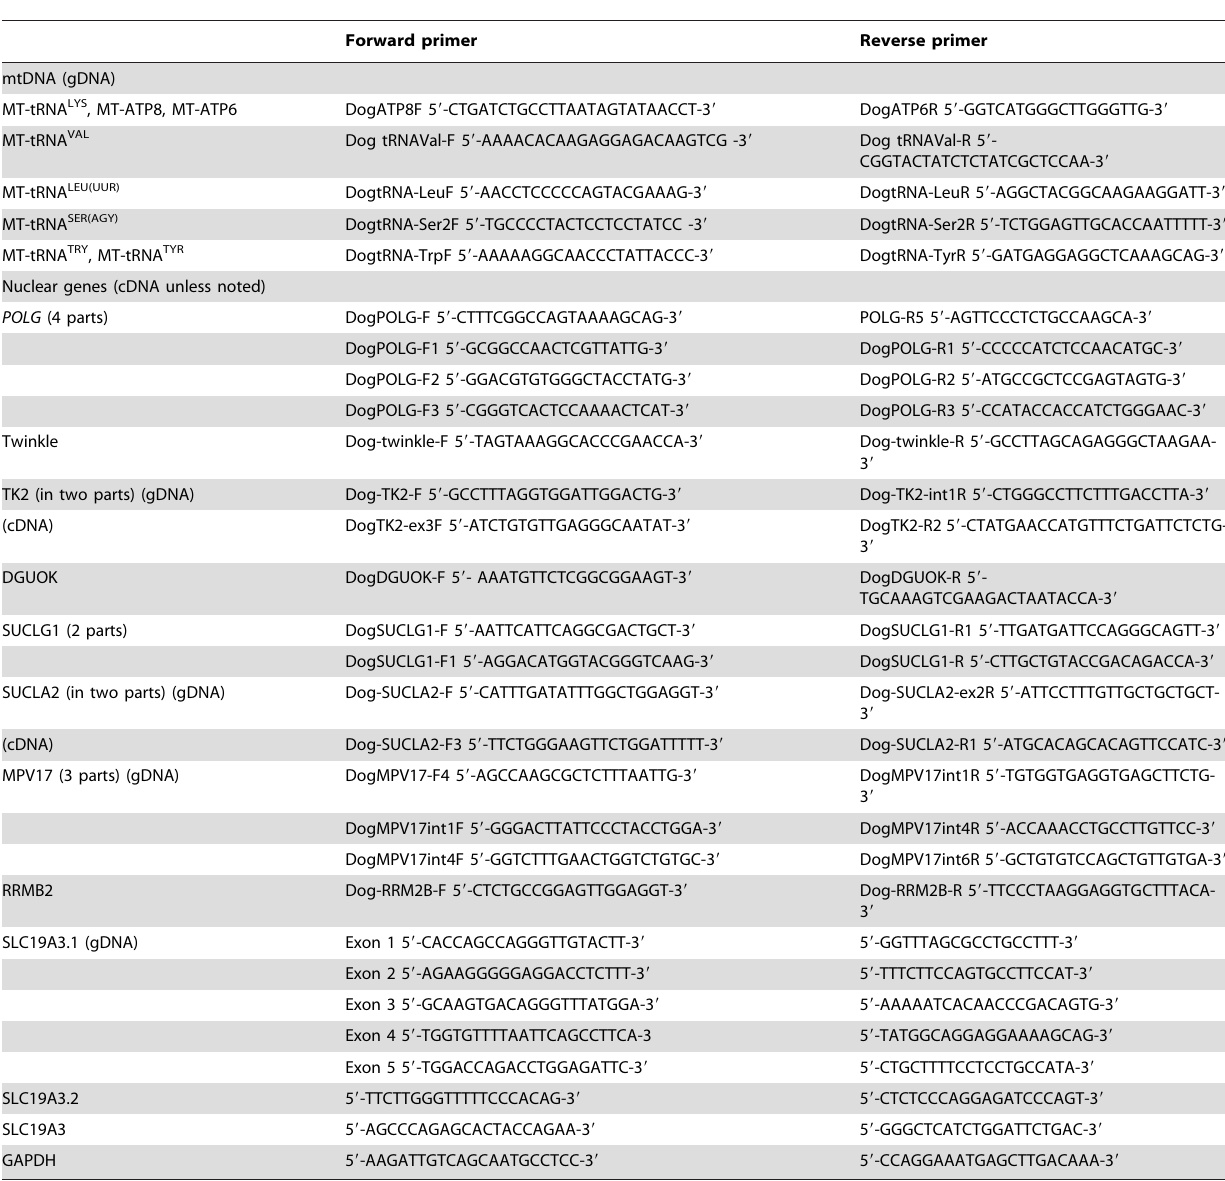
Table 5. PCR primers for amplification of mtDNA and nuclear genes.